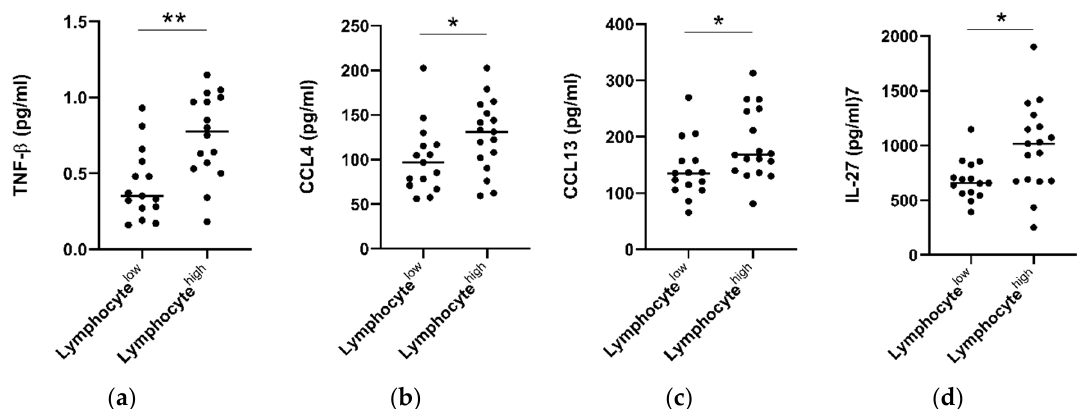
Figure 6. Patients with high tumor lymphocyte infiltration show elevated serum TNF- β , CCL4, CCL13, and IL-27. Tumor diagnostic biopsies were scored for lymphocytic infiltration in a cohort of n = 32 patients and divided into low (<50% infiltration, n = 15) and high (>50%, n = 17) cohorts. Pre-treatment cytokine levels were analyzed between groups and TNF- β , CCL4, CCL13, and IL-27 levels were observed to be elevated in EAC patients with high levels of lymphocytic infiltration. A Mann–Whitney test was used to compare lymphocyte low and high populations, * p < 0.05, ** p < 0.01. TNF = Tumor Necrosis Factor, IL = Interleukin.